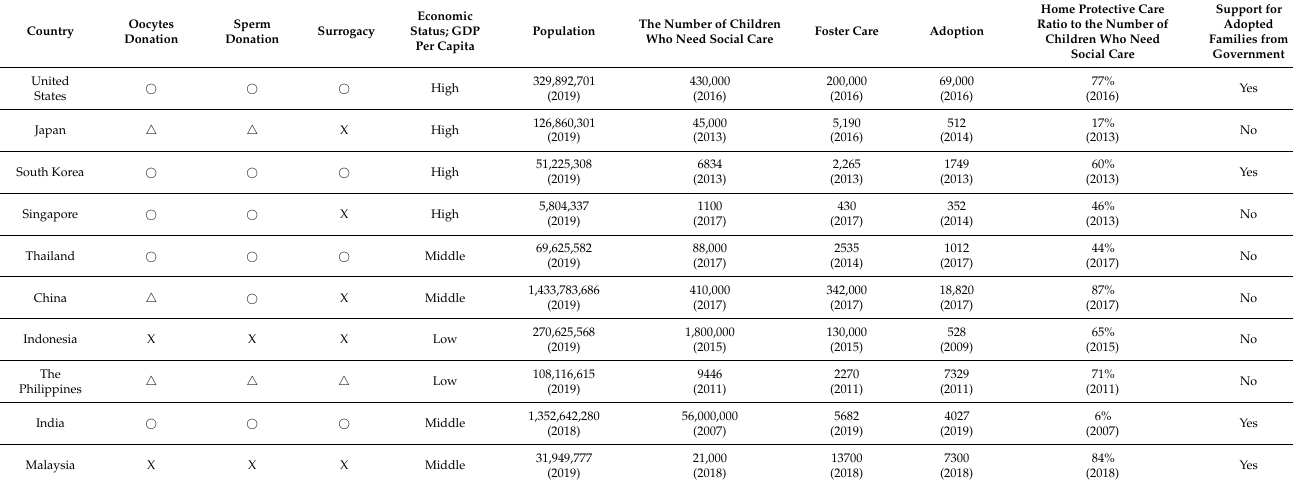
Table 1. Reproductive medicine practice and social care in the United States and Asian